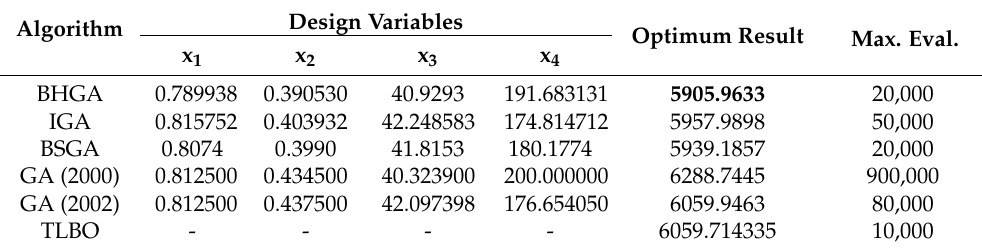
Table 9. Comparison of the BHGA optimization results with literature for the pressure vessel problem.